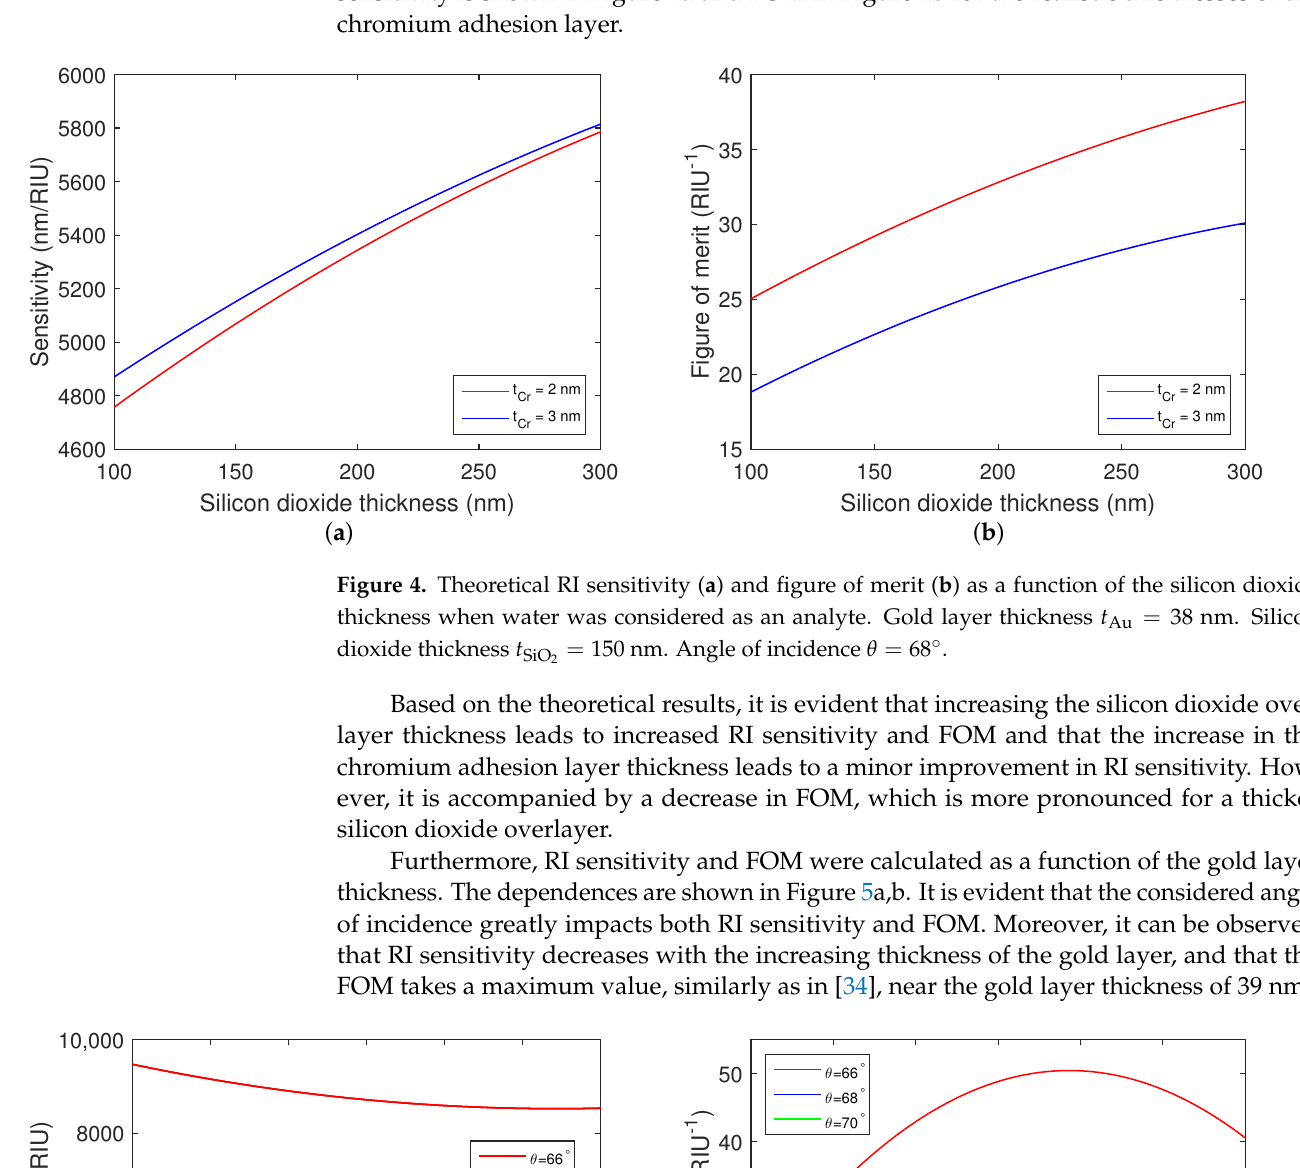
= 150 nm. Chromium layer 2